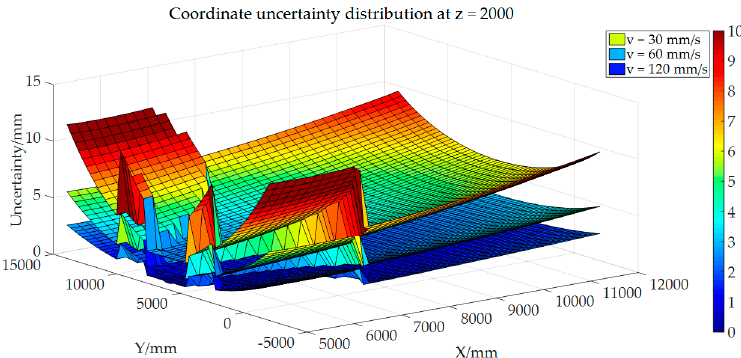
Figure 9. Coordinate uncertainty distribution of points at z = 1000. Appl. Sci. 2018 , 8 , x FOR PEER REVIEW